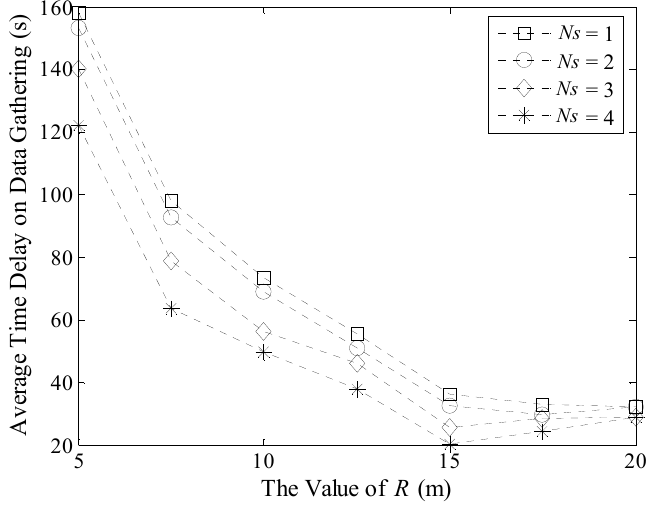
Figure 21. Average time delay on data gathering (100 m × 100 m, 200 nodes).